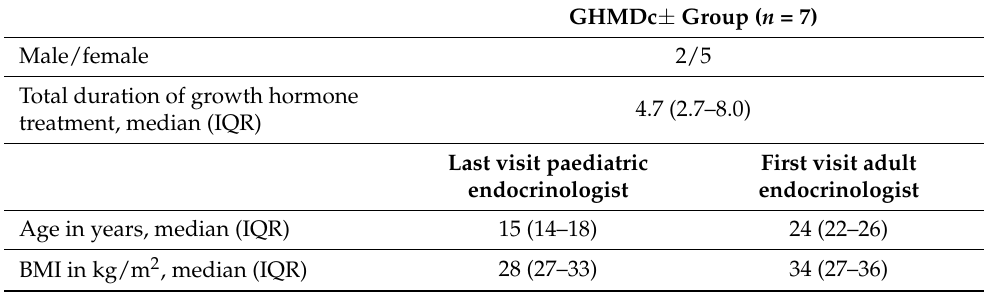
Table 4. Characteristics GHMDc ±